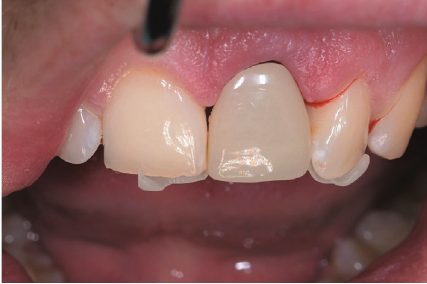
Figure 11: Temporary shell restoration with the lateral wings seated on the adjacent teeth.